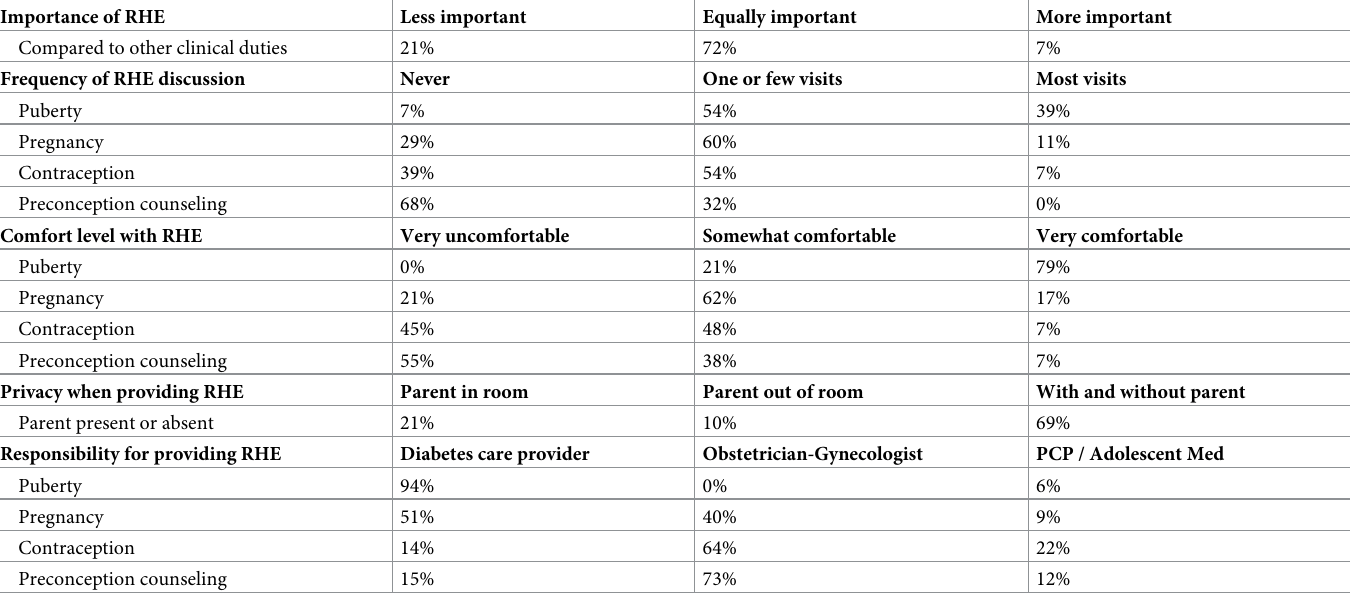
Table 1. Diabetes care provider attitudes and behaviors regarding RHE (n =